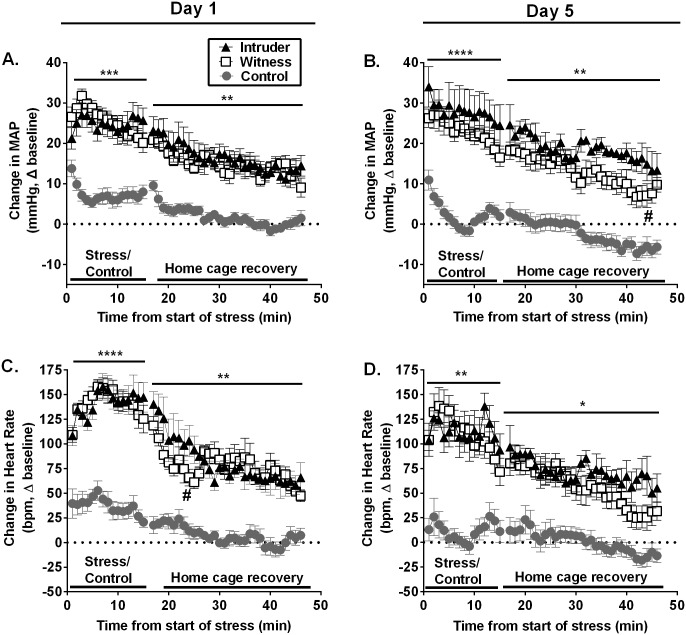
Hemodynamic and tachycardic response to social defeat and witness stress on the first and fifth exposure to stress.Physical interaction with the resident in the form of social defeat (intruder) and witnessing such an interaction produced nearly identical increases in mean arterial pressure (MAP) on days 1 (A) and 5 (B) of stress exposure above that of controls. Similarly, the heart rate (HR) response was also equally elevated in intruder and witness groups on days 1 (C) and 5 (D) of stress, significantly above that of controls. Upon being returned to their home cage, MAP and HR exhibited a time dependent decreases during the 30-minute home cage recovery period. *p<0.05, **p<0.01, ***p<0.001, ****p<0.0001 intruders/witnesses vs. controls; There were two instances during the home cage recovery where the cardiovascular response in witnesses recovered more quickly than intruders (#p<0.05 witnesses vs. intruders).